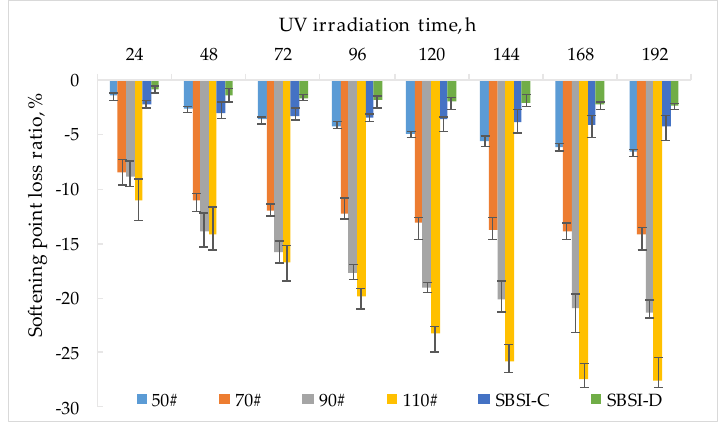
Figure 7. The softening point loss rate of asphalt with different UV irradiation time.